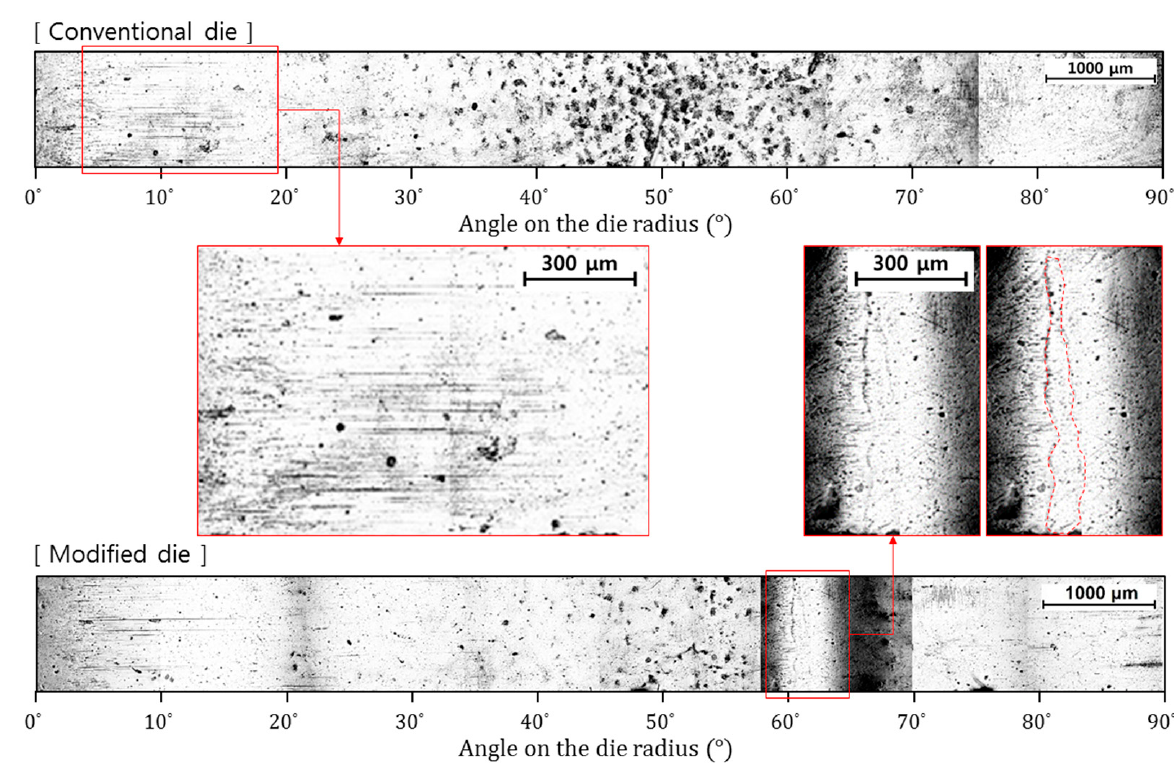
Figure 14. The tool wear surface for the conventional and modified dies observed by OEM.